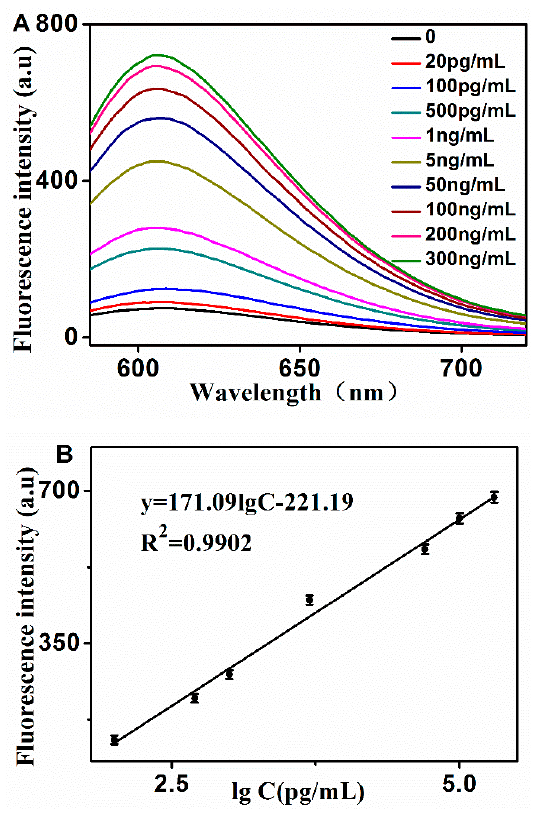
Figure 4. ( A ) Fluorescence emission spectra in the presence of PSA with different concentrations. From bottom to top: 0 to 300 ng · mL − 1 , respectively. ( B ) The relationship curve of the fluorescence response to PSA concentration. The experimental conditions: H1, 20 nM; H2, 30 nM; H3, 30 nM; GO, 15 µ g · mL − 1 . Table 1. Performance comparison of different methods.